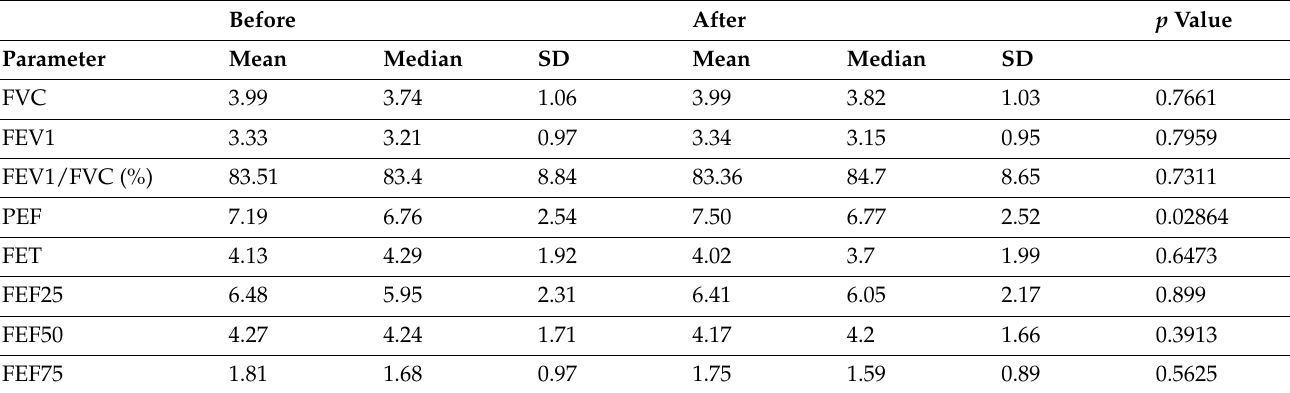
Table 9. Results of the spirometry examination of the FFP2 mask using the Wilcoxon signed-rank test. A p value < 0.05 was considered statistically significant. Statistically significant results are shown in bold.